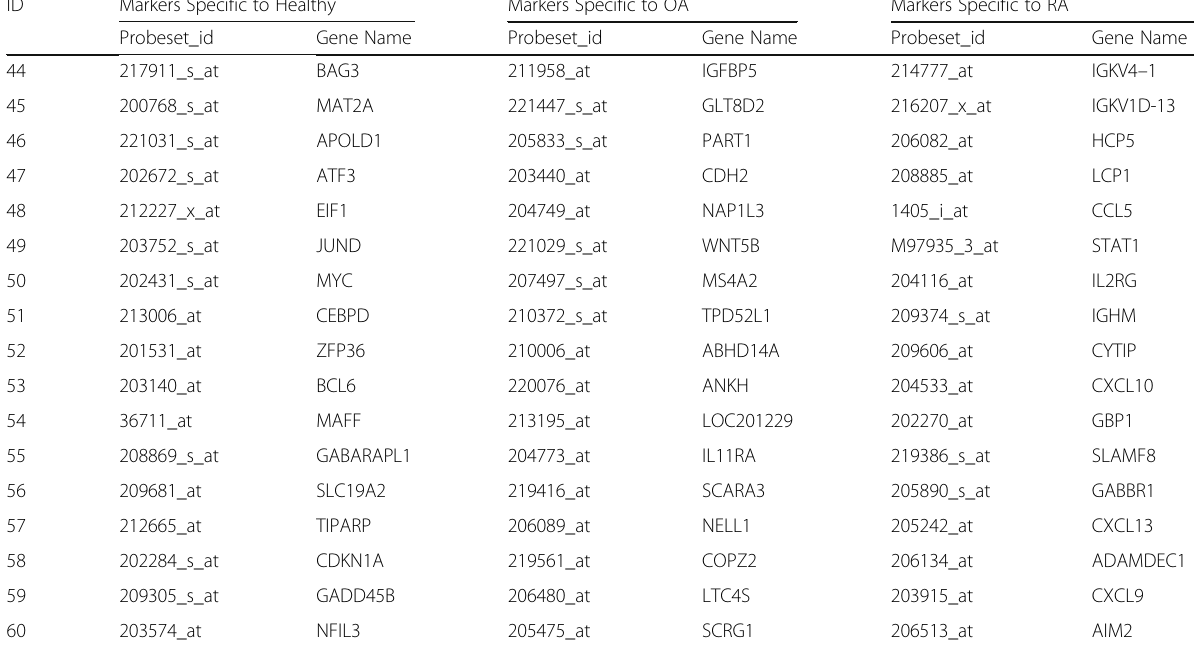
Table 1 Top Genes that are specific to healthy, OA, and RA synovium (Continued) ID Markers Specific to Healthy Markers Specific to OA Markers Specific to